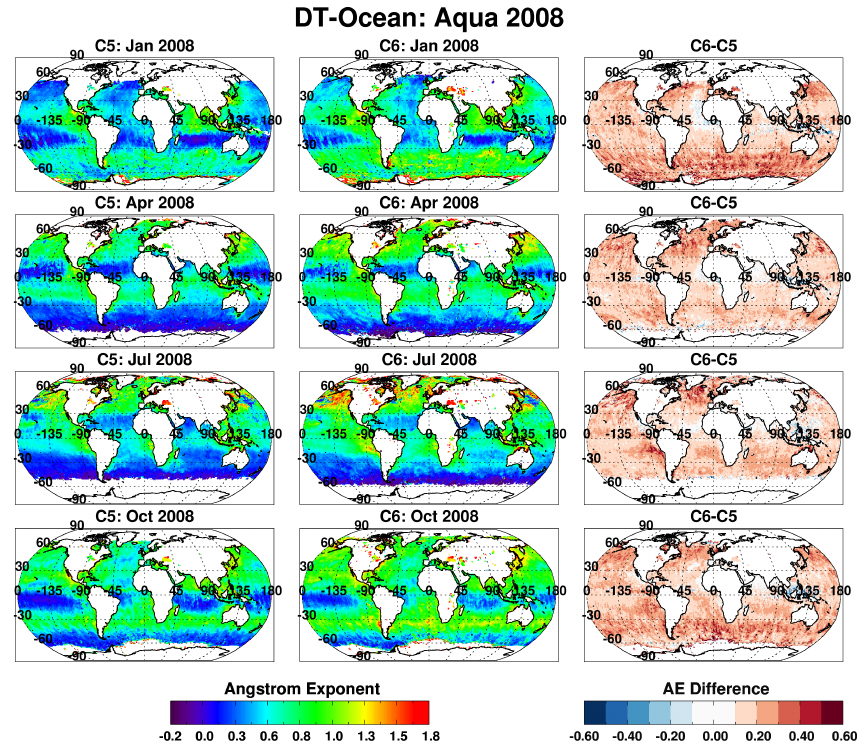
Figure 15: Gridded, monthly averaged 1°x1° AE (at 0.86/0.55 µ m) over ocean retrieved from Aqua for Jan, Apr, Jul and Oct 2008. For each row, the left panel is an aggregated product produced from C5, the middle panel is from C6, and the right panel are differences C6-C5.